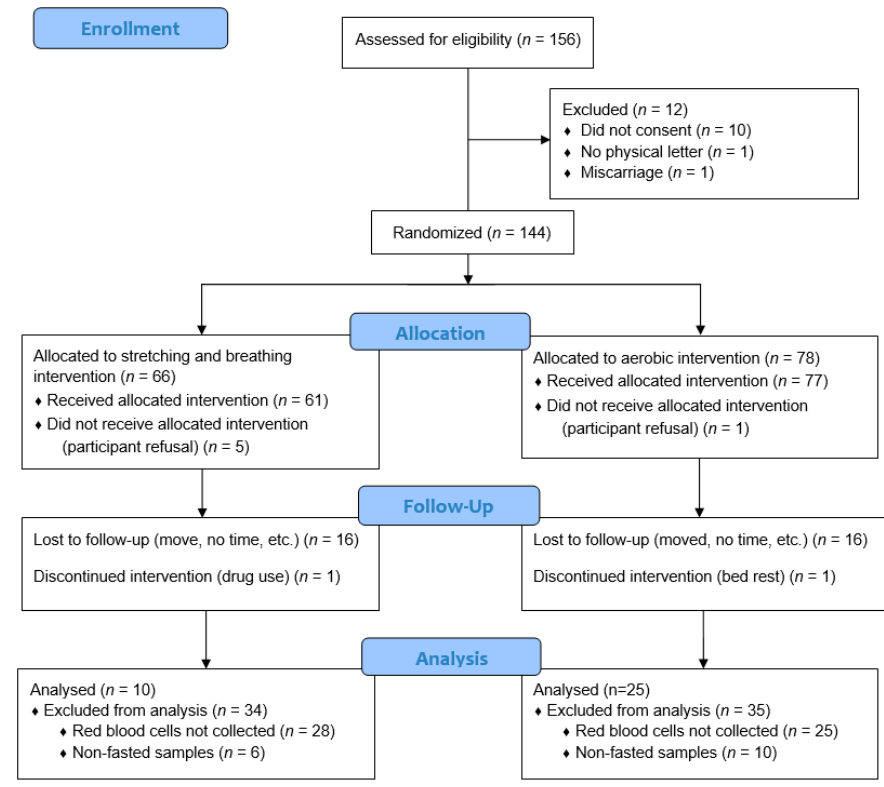
Figure 1. CONSORT Diagram.